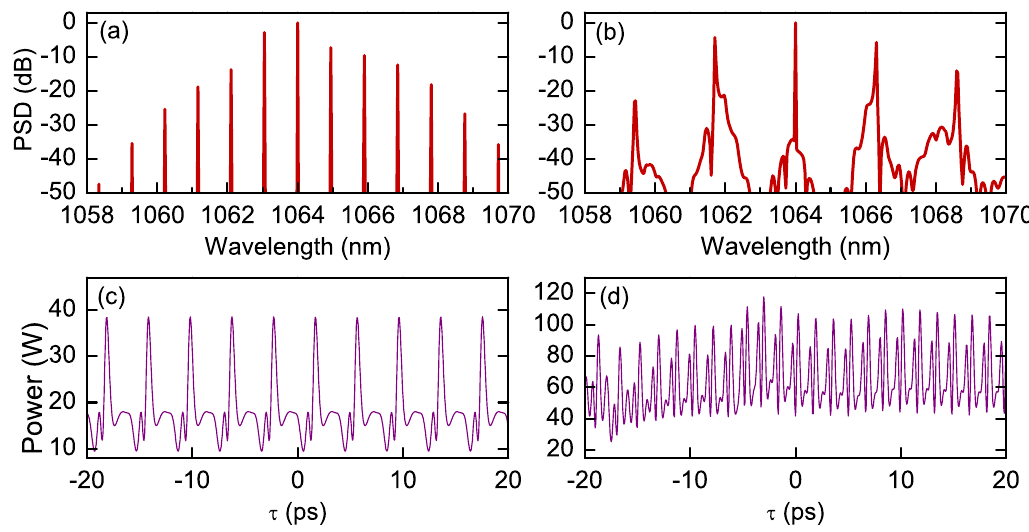
Figure 5. Numerical simulation of Equation (11), using the parameters of the system in Ref. [48]. ( a ) Input power 2 W, δ 1 = 0.001. ( b ) Input power 7 W, δ 1 = 0.01. ( c , d ) Details of the respective temporal